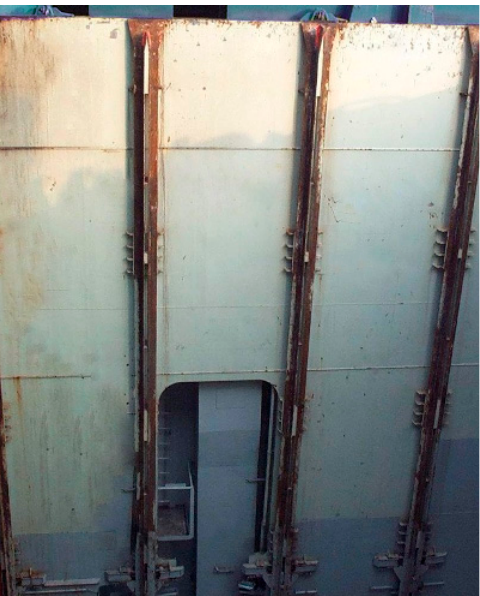
Figure 2. Example of the vertical cell guides in the inner hull of container ship representing the hold.